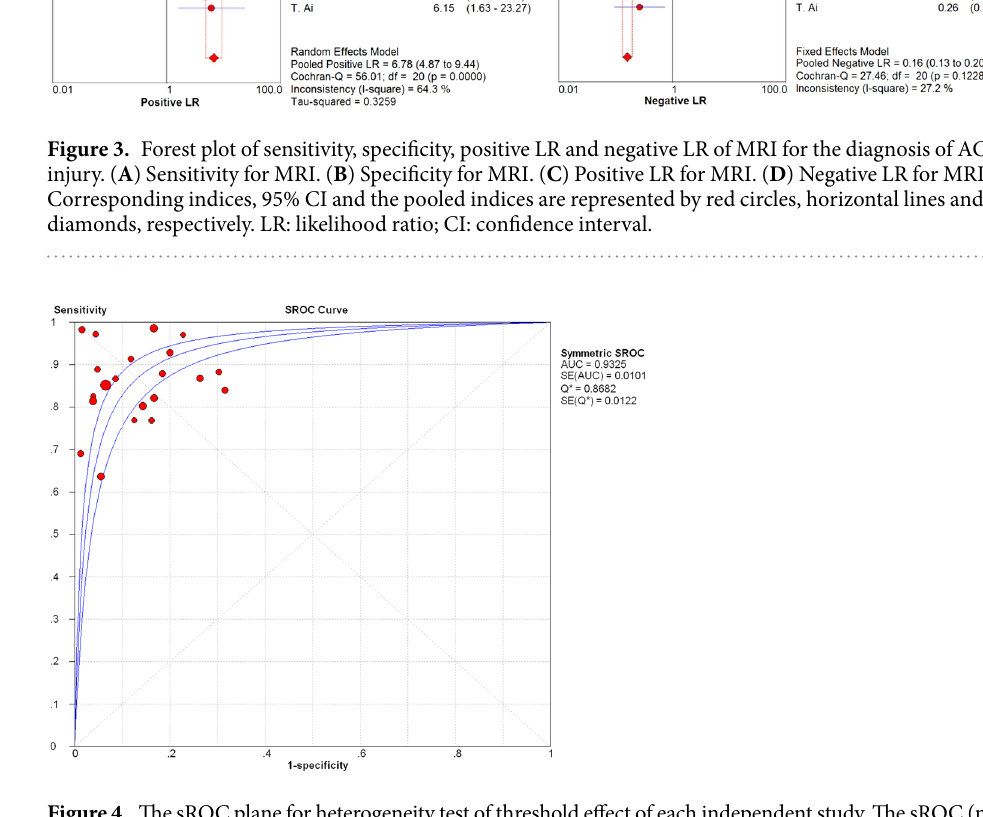
Another important factor that affects the diagnostic accuracy is the MRI sequence. Oei et al . (2003) reported that improving the MRI sequence could improve diagnostic accuracy 37 . However, no study has yet compared the accuracy of diagnosis between different MRI sequences. Our meta-analysis provides evidence that there are no